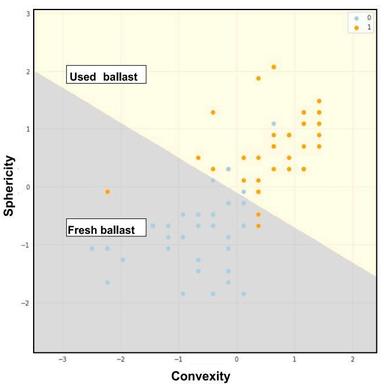
Logistic regression classified fresh and used ballast.